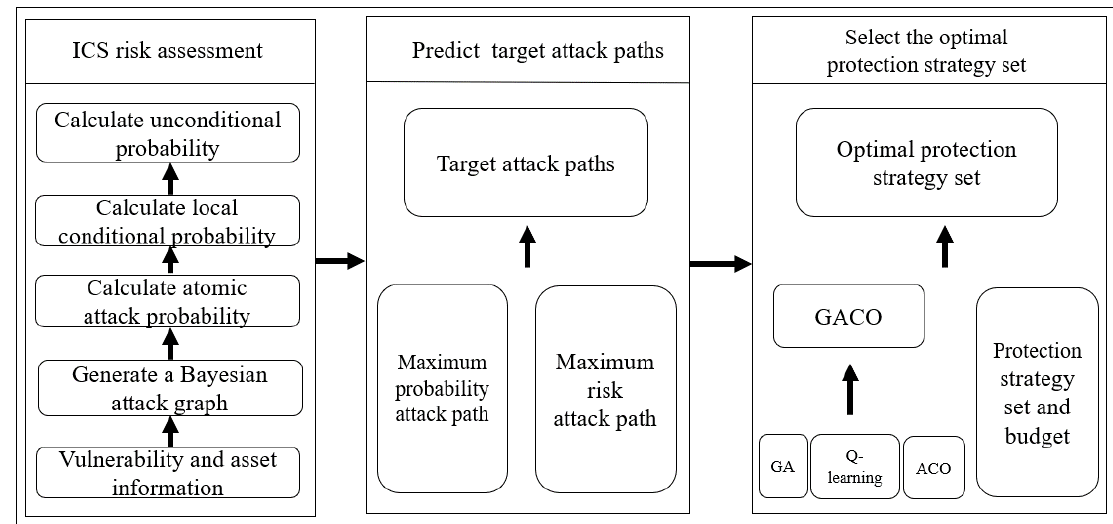
Figure 1. Protection strategy selection